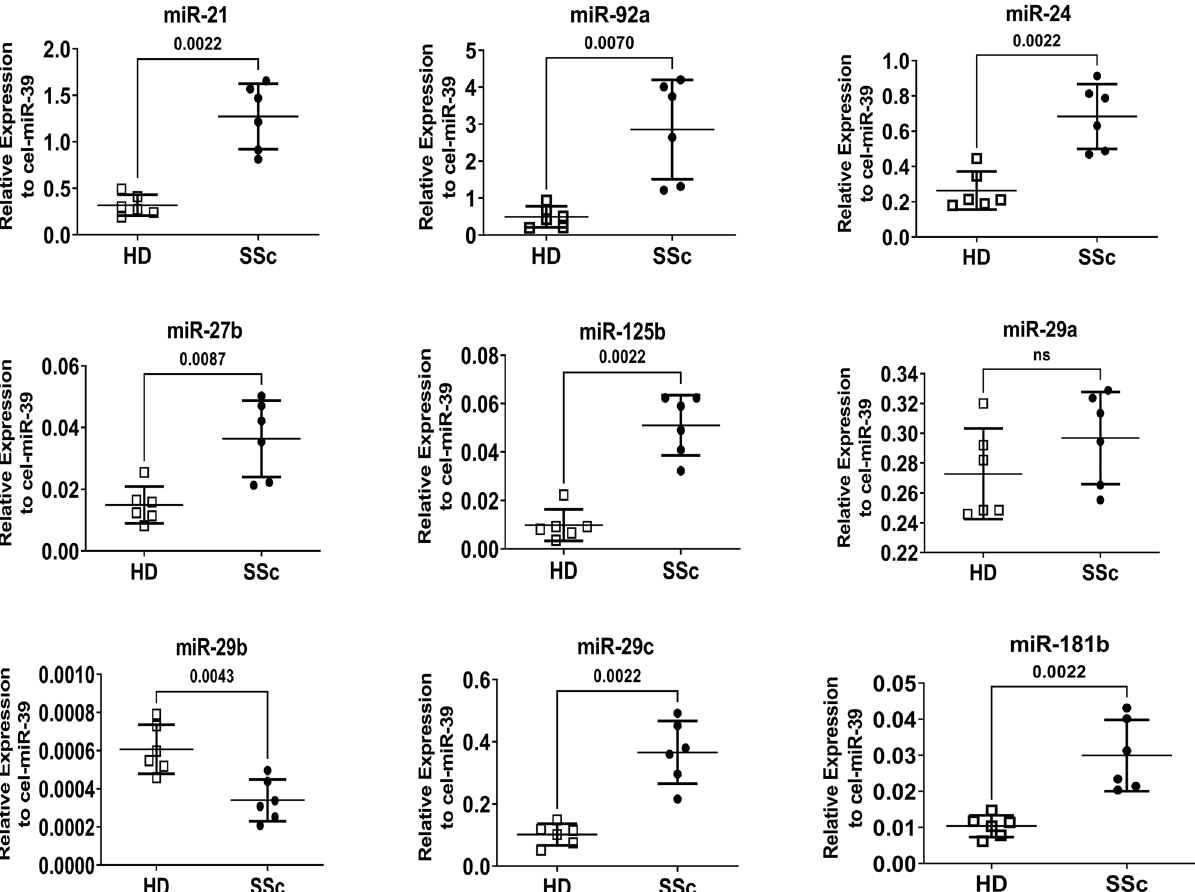
Figure 5: Content levels of miRNAs present in serum of HD and SSc patients. The expression of the indicated microRNAs ( miRNAs ) was measured ( real - time quantitative polymerase chain reaction ) in the serum of healthy donor ( HD ) and SSc patients ( SSc ) samples. miRNA levels as expressed as relative expression normalized to levels of cel - miRNA - 39. Horizontal lines indicate the mean value and standard deviation range. Mann – Whitney test was used to detect di ff erences among HD and SSc